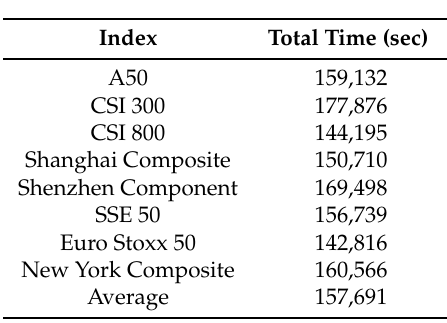
Table 7. Calculation